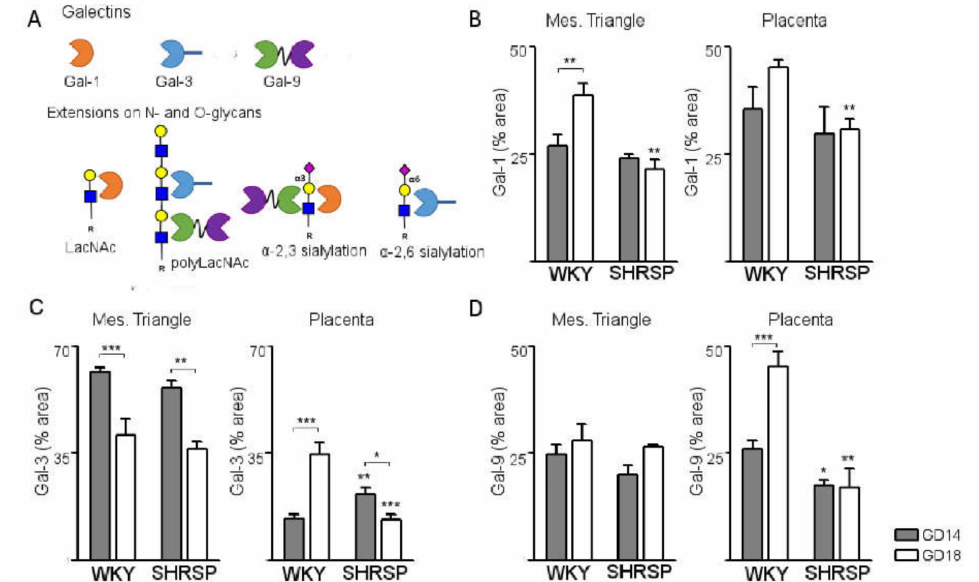
Figure 5. Temporal variation of the placental galectin signature associated with the development of SPE in SHRSP pregnancies. ( A ) Schematic diagram depicting the specific glycan moieties recog- nized by the different stress-sensitive galectins determined in this study. ( B ) Immunohistochemical analysis of Gal-1 expression in maternal (mesometrial triangle, left panel) and trophoblastic layers (placenta, right panel) of WKY and SHRSP implantations. SHRSP placentas failed to upregulate Gal-1 expression as gestation progressed to GD18. ( C ) Placental galectin-3 expression levels in both pregnancy models. Onset of SPE was marked by a significant upregulation of Gal-3 in trophoblastic compartments of the SHRSP placenta. ( D ) Immunohistochemical evaluation of Gal-9 expression in both models. SHRSP displayed decreased trophoblastic expression of Gal-9 on GD14, with a failure to upregulate levels of this lectin towards GD18. The results are presented as the means ± SEM, n = 5–7 animals/group. In all the panels, * p < 0.05, ** p < 0.01 and *** p < 0.001 as evaluated by two-way ANOVA and Bonferroni post-hoc